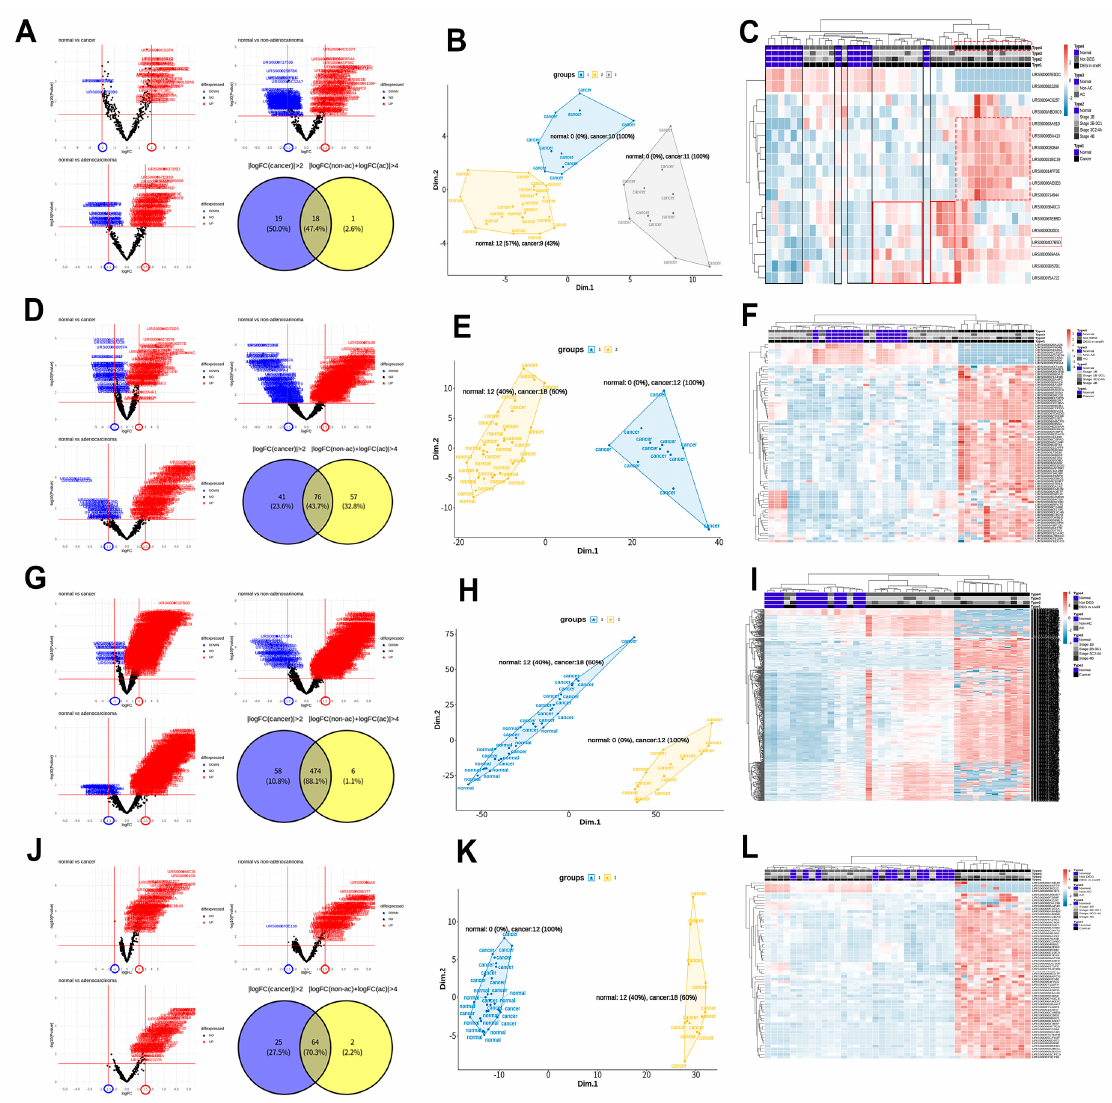
Figure 3. Statistical screening of exosome snoRNAs, snRNAs, tRNAs, and yRNAs for the diagnosis of cervical cancer. ( A ) Volcano plots and a Venn diagram of 18 selected snoRNAs. ( B ) A clustered multidimensional scaling (MDS) scatter plot for 42 samples using the 18 snoRNAs. ( C ) A heatmap of the 18 snoRNAs in the normal and cancer groups. ( D ) Volcano plots and a Venn diagram of the selected 76 snRNAs. ( E ) A clustered MDS scatter plot of the 42 samples using 76 snRNAs. ( F ) A heatmap of the 76 snRNAs measured in the normal and cancer groups. ( G ) Volcano plots and a Venn diagram of the selected 474 tRNAs. ( H ) A clustered MDS scatter plot of the 42 samples using 474 tRNAs. ( I ) A heatmap of the 474 tRNAs in the normal and cancer groups. ( J ) Volcano plots and a Venn diagram of the selected 64 yRNAs. ( K ) A clustered MDS scatter plot of the 42 samples using the 64 yRNAs identified. ( L ) A heatmap of the 64 yRNAs in the normal and cancer groups.